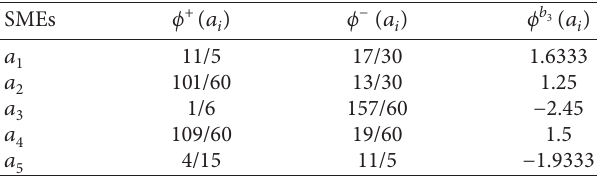
Table 10: The net flow of environmental